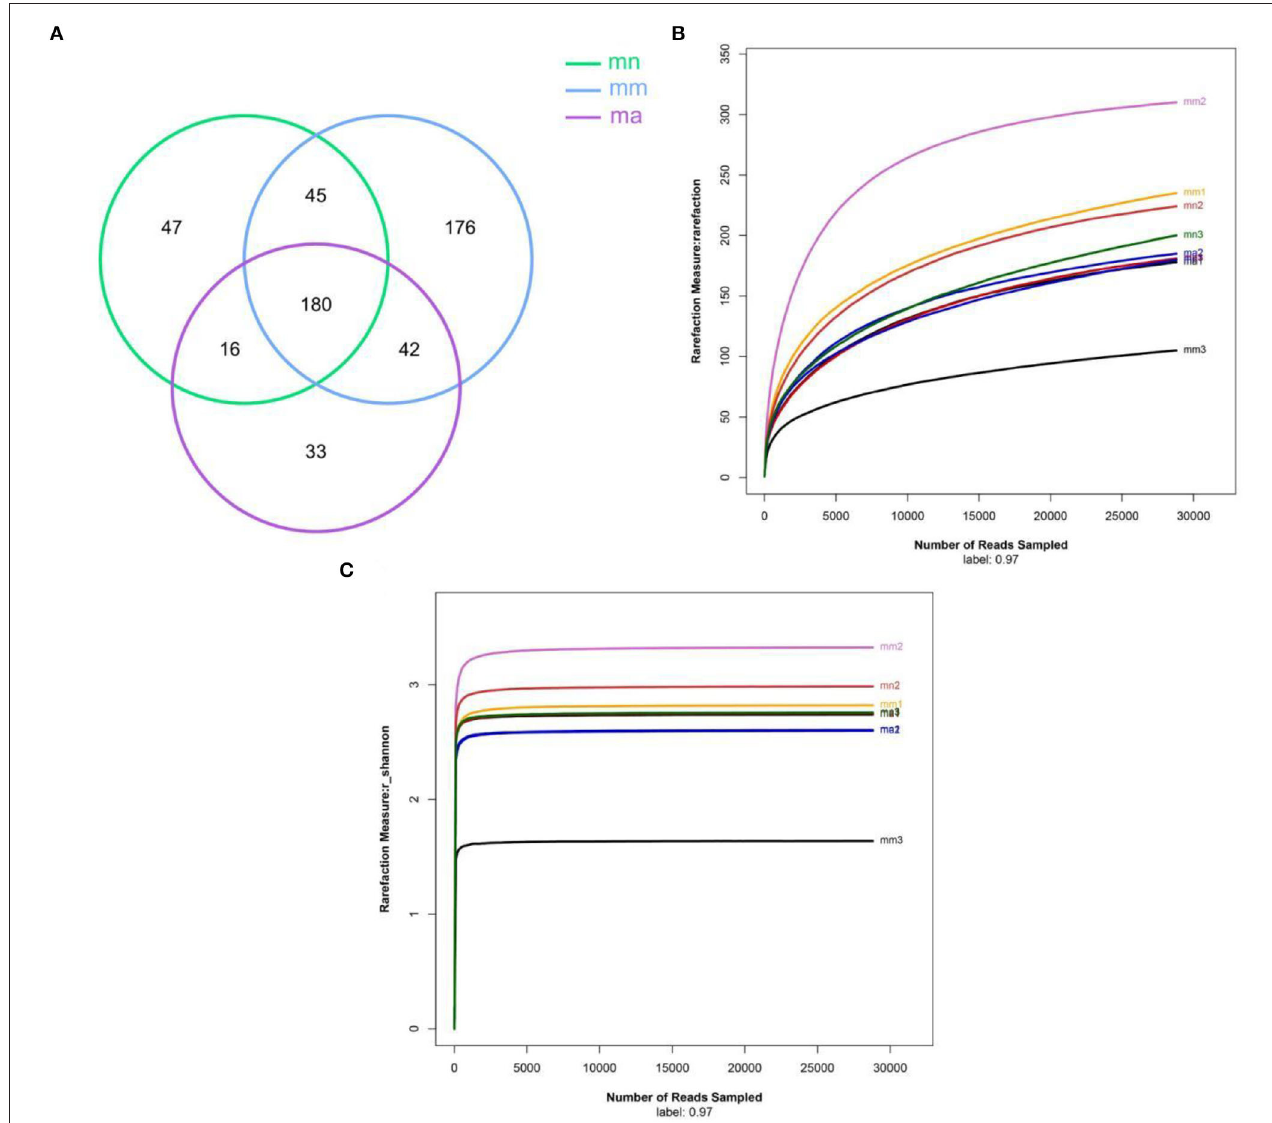
FIGURE 3 | (A) Venn diagram: the distribution of the number of intestinal mucosal bacterial OTUs in each group of samples. Green, blue, and purple represent the mn, mm, and ma groups, respectively. (B) Dilution curve of intestinal mucosal bacteria in each group of samples. Horizontal coordinate: the amount of randomly selected sequencing data; vertical coordinate: the number of observed OTUs. (C) The Shannon–Wiener curve of intestinal mucosal bacteria for each group of samples. mn: normal group; mm: model group; ma: QWBZP crude polysaccharide treatment